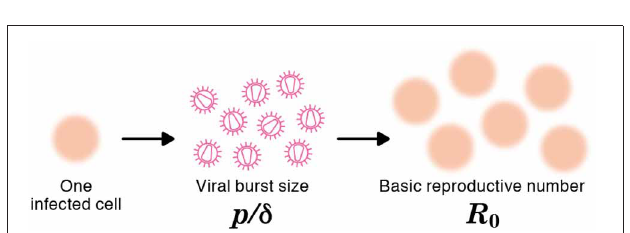
FIGURE 3 | The burst size and the basic reproductive number of a virus. The burst size is defined as the expected number of virions produced by one infected cell over its life-time (e.g., p / δ = 9 in the figure). The basic reproductive number, R 0 , is defined as the expected number of newly infected cells resulting from one infected cell during its life-time (e.g., R 0 = 6 in the